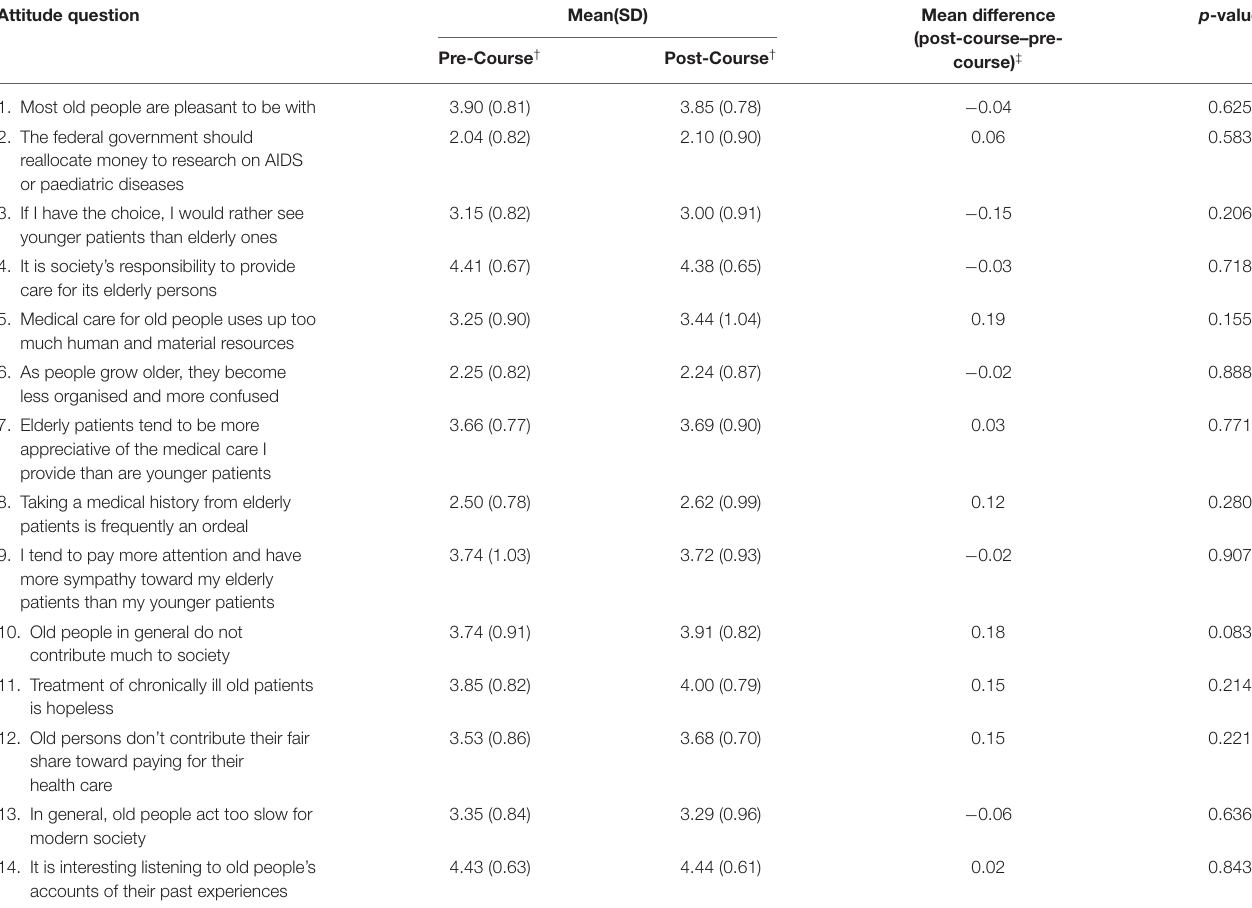
TABLE 1 | Students’ means, standard deviations, and P -value of attitudes toward older people for each question. Attitude